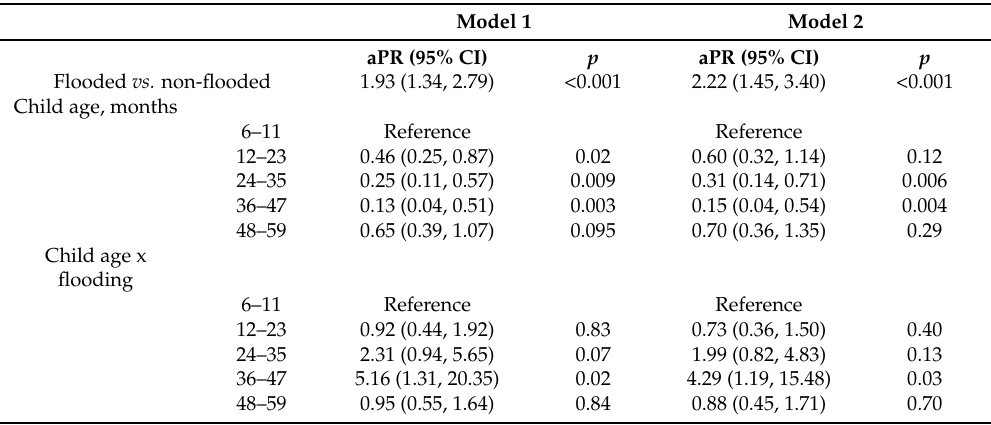
Table A2. Final model results after implementation of propensity score matching to the sample of children inhabiting repeatedly flooded and non-flooded villages.